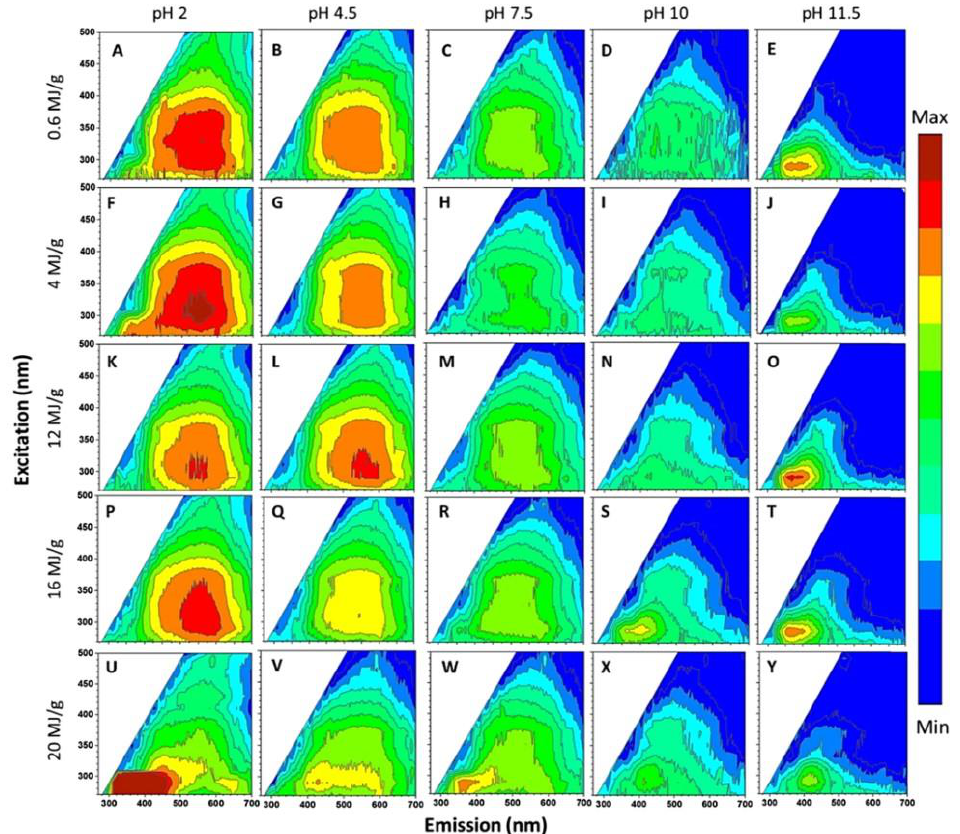
Figure 8. 2D PL spectra of GO dispersions under different pH and ultrasonic conditions. Reprinted with permission from [57]. Copyright 2017, American Chemical Society.